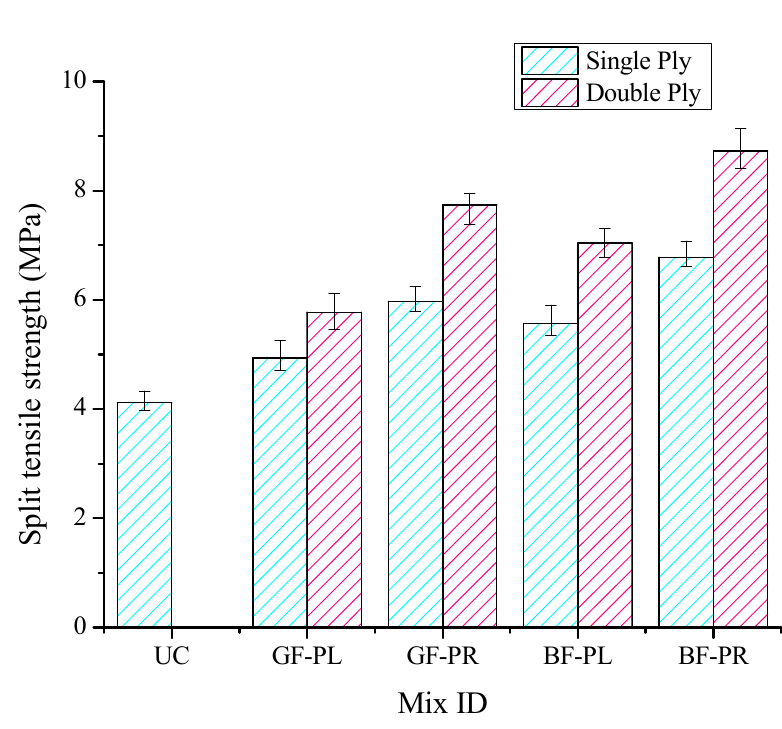
Figure 13. Split tensile strength.